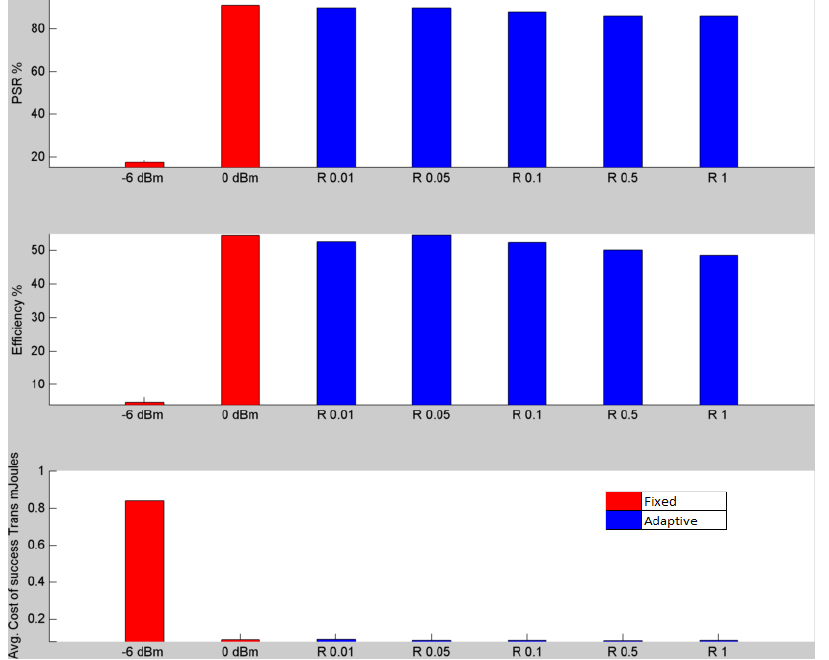
Figure 6. Comparison of the efficiency and average cost of successful transmission based on the PSR when the distance between the sensor and the hub is 24 m and collected during the busy hour. The minimum energy consumption of fixed power is achieved at 0 dBm, primarily because it has much higher PSR and efficiency than at −6 dBm. The adaptive protocol consumes 6% less energy than the fixed power transmission at 0 dBm when R = 0.5. The efficiency of the fixed power transmisison at 0 dBm is a touch higher than that of adpative protocol at R =